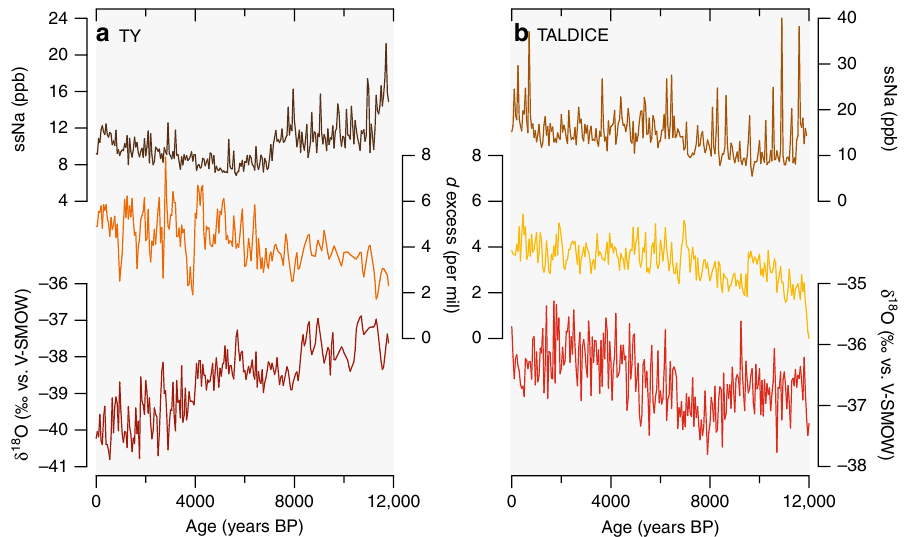
Fig. 3 Holocene ice core records. a sea salt sodium concentration in part per billion (dark brown line), deuterium excess in ‰ vs. V-SMOW (orange line) and δ 18 O in ‰ vs. V-SMOW (dark red line) in Taylor Dome ice core 33 – 35 . b sea salt sodium concentration in part per billion (brown line), deuterium excess in ‰ vs. V-SMOW (yellow line) and δ 18 O in ‰ vs. V-SMOW (red line) in TALDICE ice core. All ice core records were resampled on a 50-year time